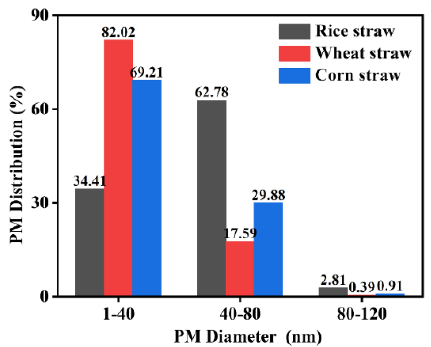
Figure 6. The size distribution of PM emitted from crop straws.